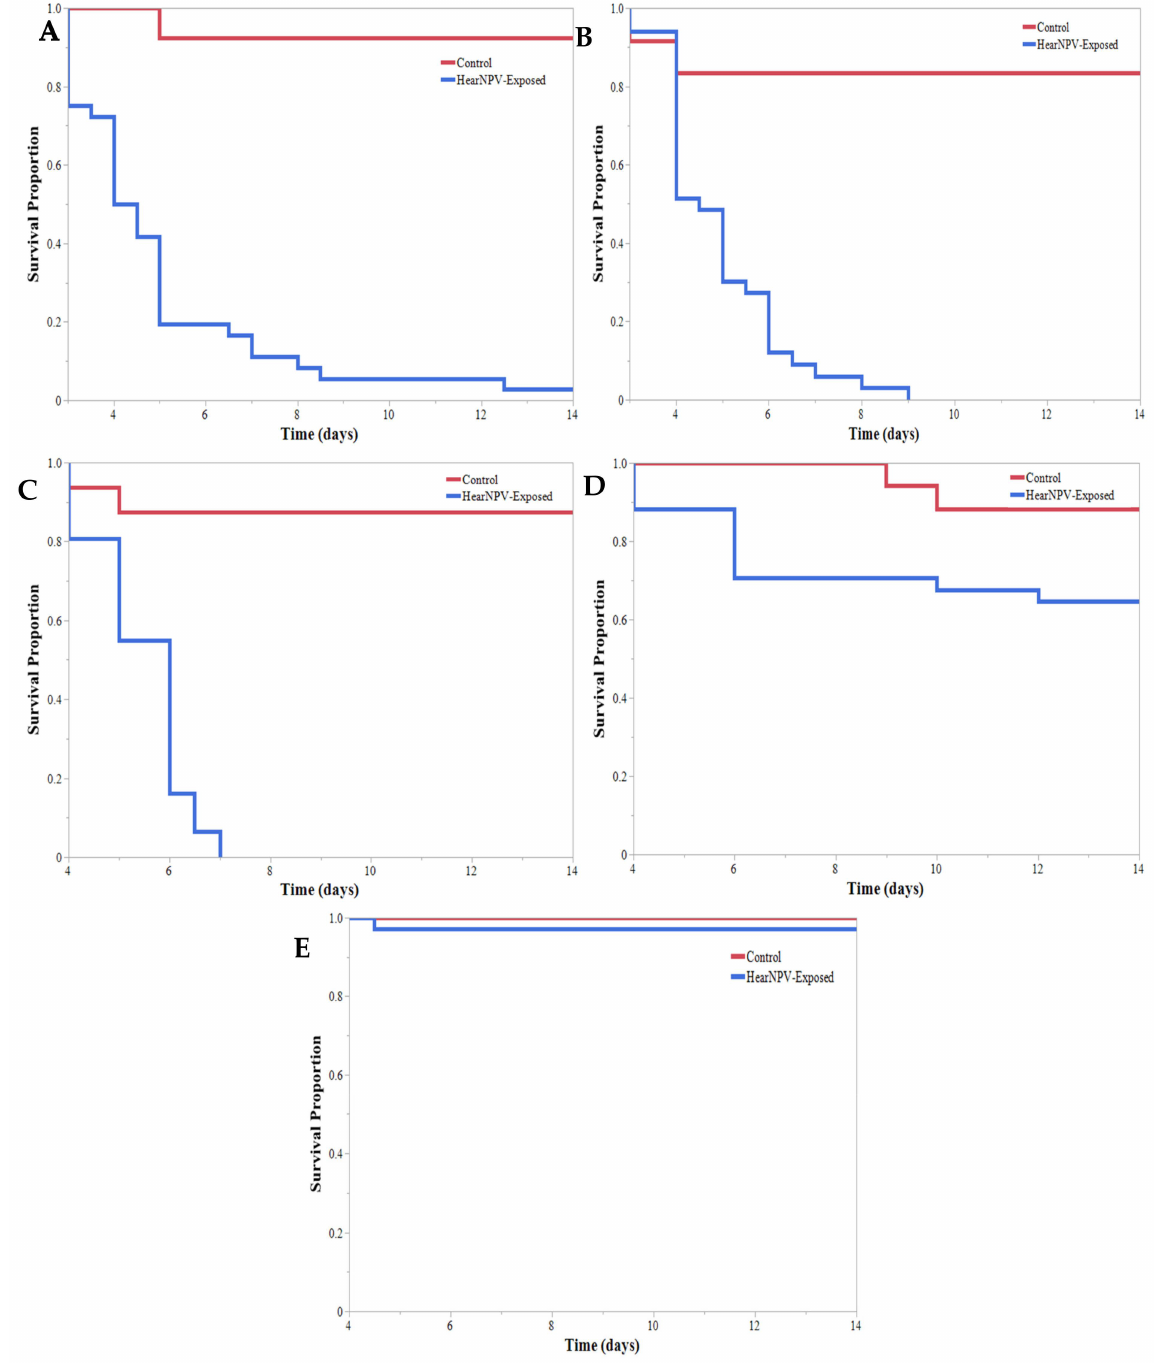
Figure 2. Helicoverpa zea (Lepidoptera: Noctuidae) Kaplan–Meier survival curves for each larval instar reared on Helicoverpa armigera nucleopolyhedrovirus-sprayed and unsprayed V3 soybeans. ( A ) Significantly different survival curves for 1st instar larvae reared on unsprayed and virus-sprayed soybeans. Log-rank test: χ 2 = 30.924, p < 0.0001. ( B ) Significantly different survival curves for 2nd instar larvae reared on unsprayed and virus-sprayed soybeans. Log-rank test: χ 2 = 24.445, p < 0.0001. ( C ) Significantly different survival curves for 3rd instar larvae reared on unsprayed and virus-sprayed soybeans. Log-rank test: χ 2 = 30.566, p < 0.0001. ( D ) Survival curves for 4th instar larvae reared on unsprayed and virus-sprayed soybeans were not significantly different. Log-rank test: χ 2 = 7.249, p = 0.0071. ( E ) Survival curves for 5th instar larvae reared on unsprayed and virus-sprayed soybeans. Log-rank test: χ 2 = 0.4722, p =